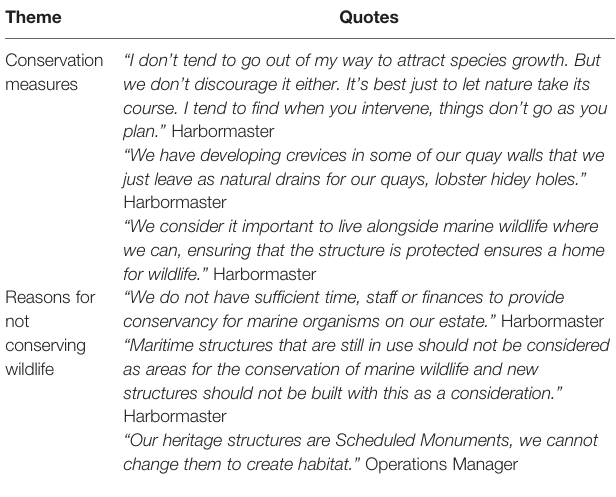
TABLE 9 | Quotes illustrating conservation measures adopted by respondents and the reasons for not adopting conservation